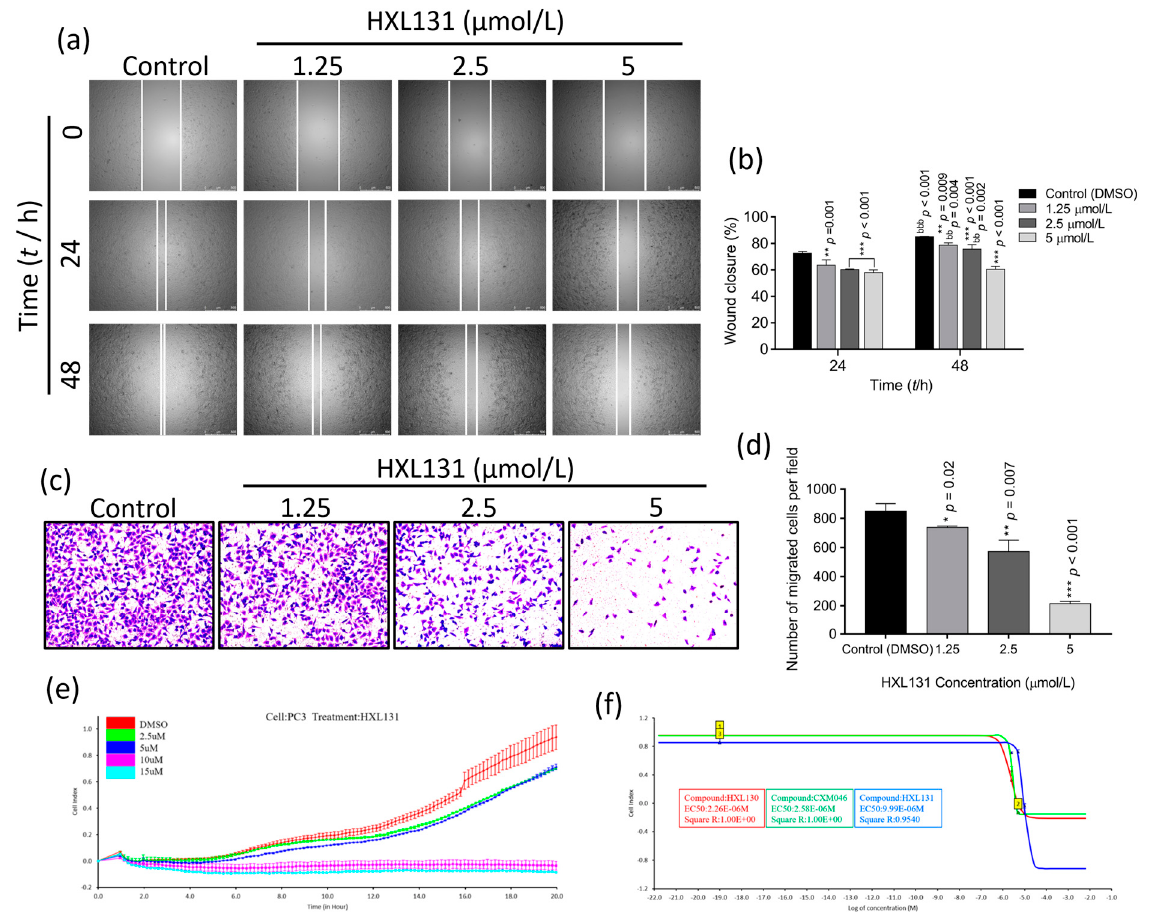
Figure 2. Effects of different concentrations of HXL131 on PC3 cell migration and safety evaluation of three compounds. ( a ) The effects of different times (0, 24, and 48 h) and concentrations of HXL131 (0, 1.25, 2.5, and 5 µmol/L) on wound-healing of PC3 cells were observed under an inverted microscope (the magnification = ×50, scale bar represents 500 µm); ( b ) Statistical results showed that HXL131 inhibited PC3 cell migration in a time- and concentration-dependent manner; ( c ) The effect of HXL131 on the ability of PC3 cells to penetrate the basement membrane of the trans-well chamber was observed using an inverted phase contrast microscope (the magnification = ×100); ( d ) Statistics of changes in the number of PC3 cells passing through the basement membrane of the trans-well chamber after the HXL131 treatment; ( e ) A real-time cellular analysis (RTCA) monitored the changing trend of HXL131’s effect on PC3 cell migration in real-time; ( f ) RTCA software analyzed the median effective concentration (EC 50 ) values of the PC3 cells that were treated with the three compounds for 20 h. Values are mean ± SD ( n = 3). * p < 0.05, ** p < 0.01, *** p < 0.001 vs. Control (DMSO) group; bb p < 0.01, bbb p < 0.001 vs. 24 h group; Multiple t -tests and two-way ANOVA were used for statistical analysis.